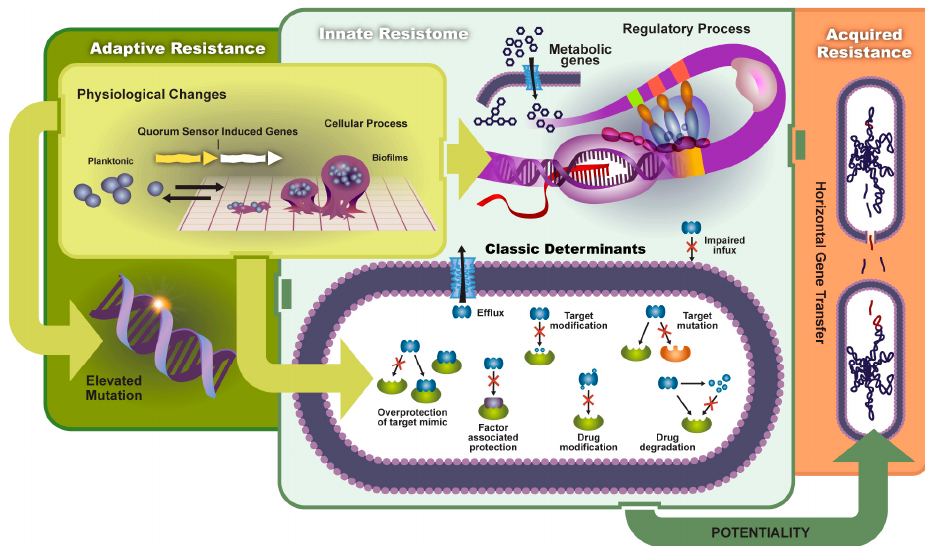
Figure 1. The transmission and mechanisms of antibiotic resistance and virulence can be divided into adaptive resistance, innate resistance, and acquired resistance. Environmental factors can prompt physiological changes and lead to: (1) elevated mutation rates; (2) changes in metabolic genes and regulatory processes; and (3) a host of classic antibiotic inactivation and resistance mechanisms (classic determinants). Such resistance and increased virulence can potentially be shared among bacteria leading to acquired resistance.